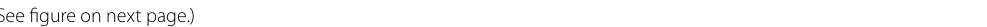
(See figure on next page.) Fig. 3 % DNA in tail in HL-60 comets after treatment with doxorubicin and incubation of nucleoids with Fpg or hOGG1 endonuclease. Data represent values generated by Fpg ( a1 ) and hOGG1 ( a2 ) incubation, that were calculated by subtracting the value of DNA damage caused in the HL-60 cells that were not treated with the respective enzyme from the DNA damage caused in cells incubated with the enzymes. Subtracted values are pointed out in light grey area marked ‘‘Fpg sites’’ and “hOGG1 sites”. b HL-60 comets, no doxorubicin treatment/no endonuclease incubation ( b 1 ); no doxorubicin treatment/Fpg endonuclease incubation ( b 2 ); no doxorubicin treatment/hOGG1 endonuclease incubation ( b 3 ); doxorubicin treatment at 0.5 μg ml − 1 /no endonuclease incubation ( b 4 ); doxorubicin treatment at 0.5 μg ml − 1 /Fpg endonuclease incubation ( b 5